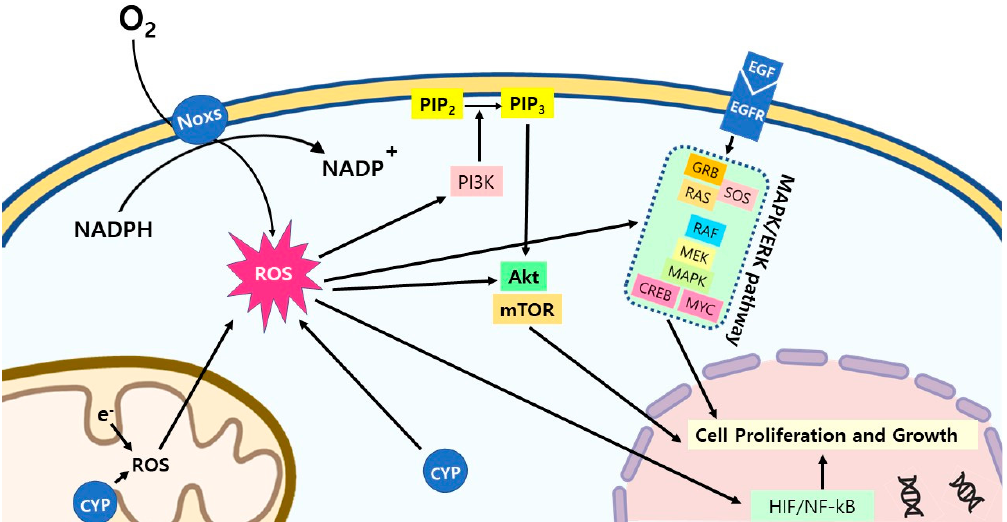
Figure 4. ROS signaling pathways in cancer cells. ROS activate multiple signaling pathways in cancer cells for the stimulation of the cell proliferation and growth. Abbreviations: CYP: cytochrome